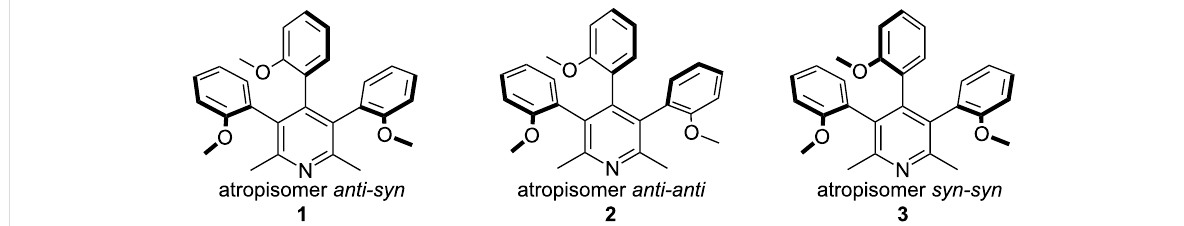
Figure 1: Structures of stereoisomers of 3,4,5-tris(2-methoxyphenyl)-2,6-dimethylpyridines determined by X-ray analysis [38].